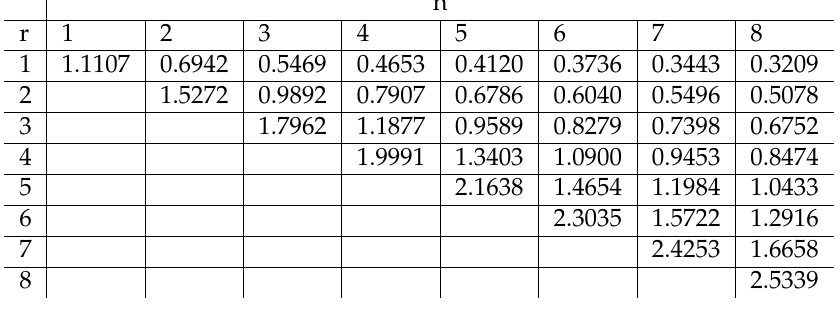
Table 1. Means of order statistics from Pareto-Rayleigh distribution ( α =2, σ =1)